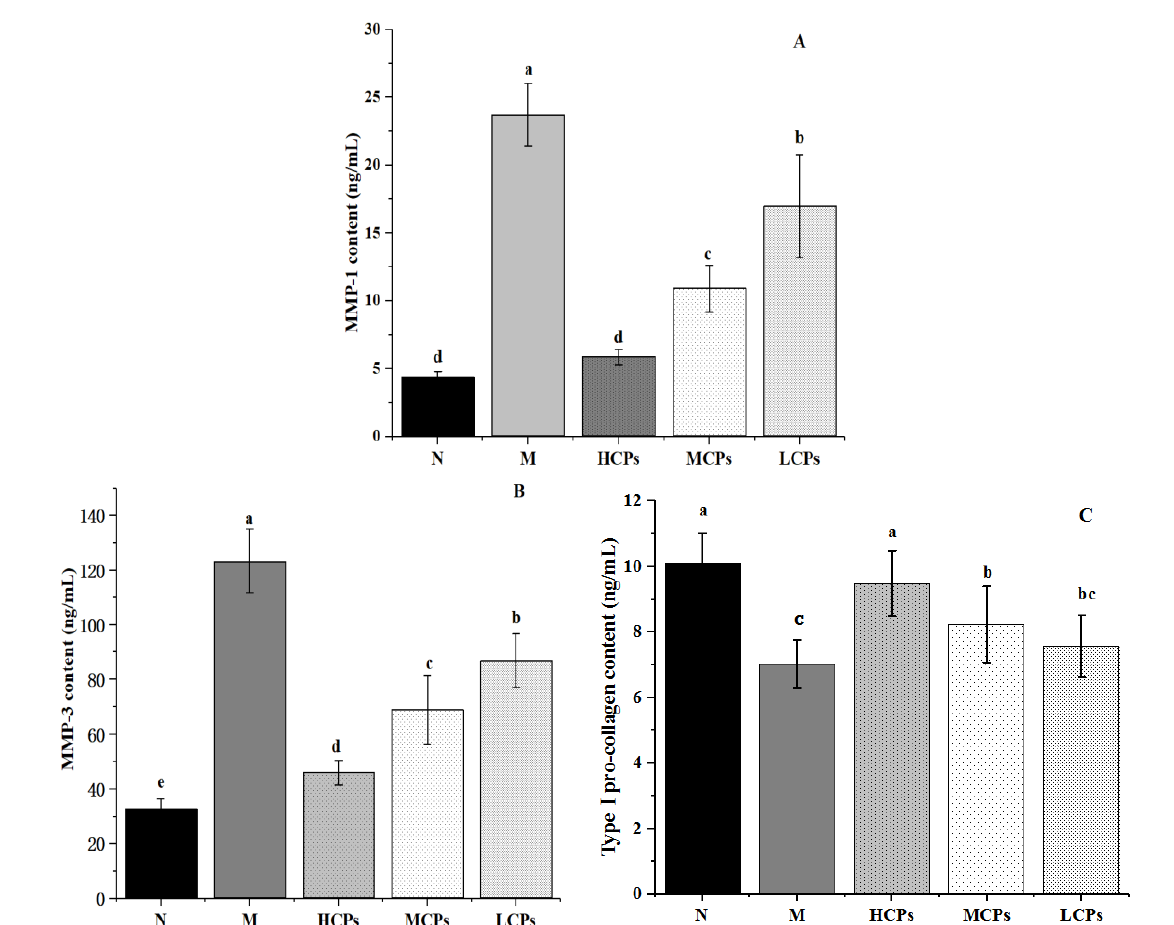
Figure 7. Effects of CPs on MMP-1 ( A ), MMP-3 ( B ), and Type I pro-collagen ( C ). Different letters in the same column indicate significant differences ( p < 0.05).